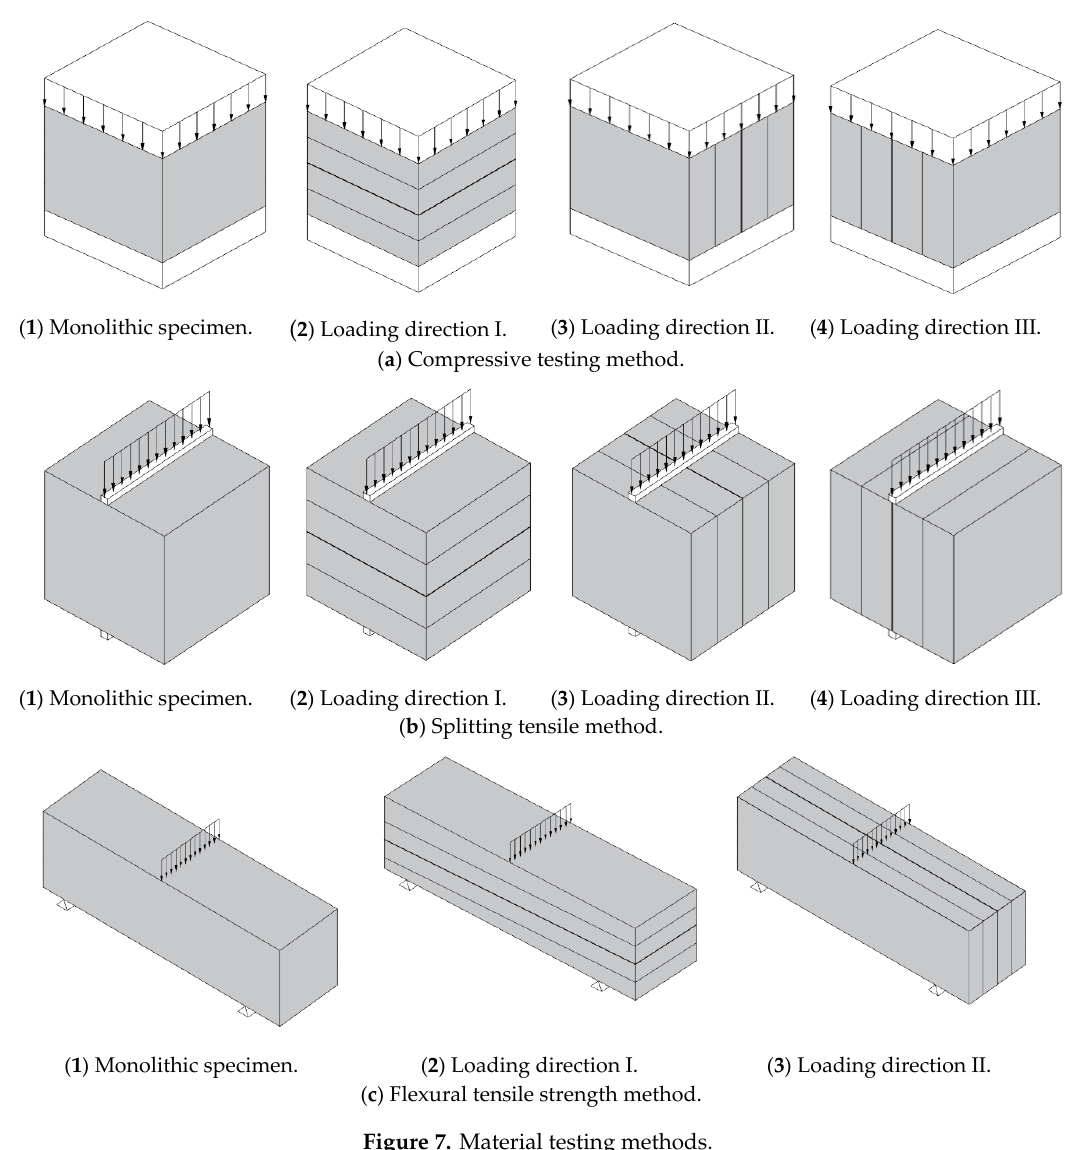
Figure 7. Material testing methods.